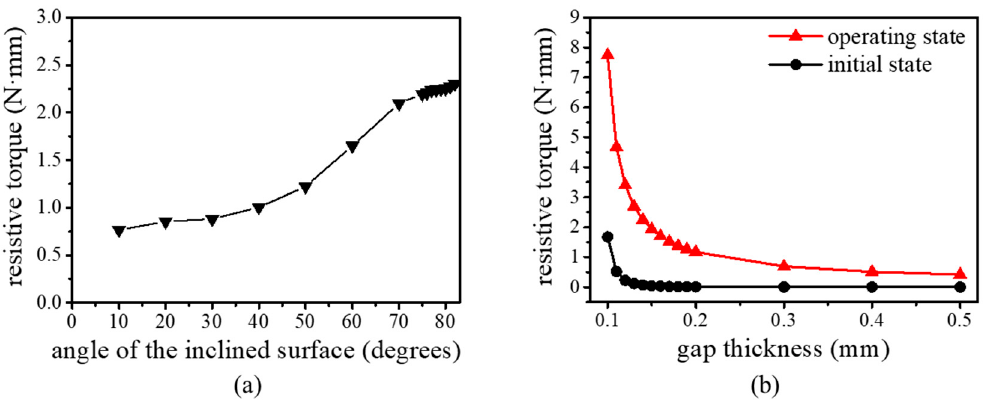
Figure 3. Simulated resistive torques as a function of the ( a ) oblique angle of the inclined surface and ( b ) gap ( b ) gap thickness.